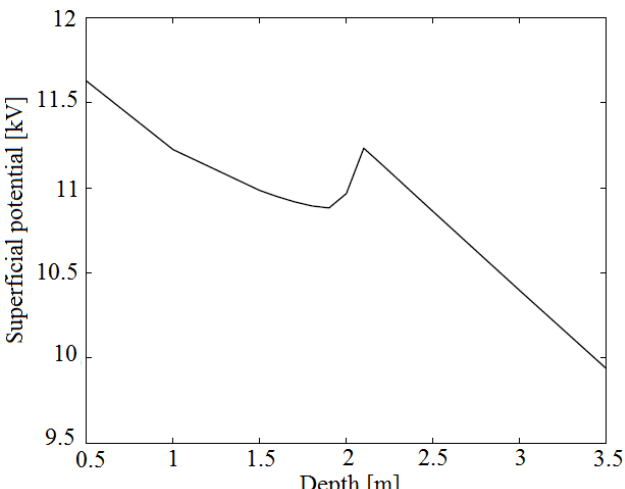
Fig. 14 Superficial potential ( V s ) versus depth ( D ).